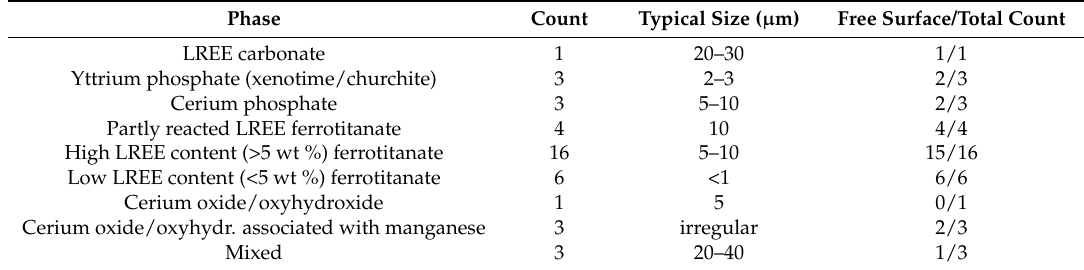
Table 7. Summary of the physical parameters of the encountered REE particles in bauxite